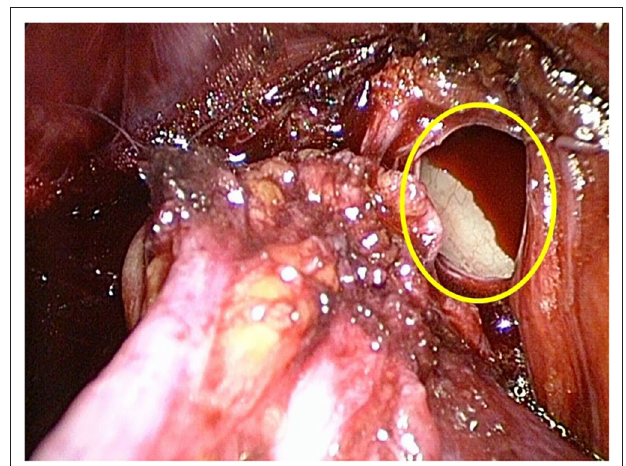
FIGURE 1 | Intraoperative view of the open right iliac vein (yellow oval), despite the injury no bleeding is seen due to the preperitoneal pressure of 12 mmHg.